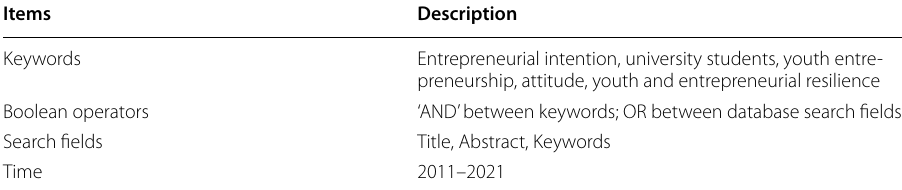
Table 1 Protocols followed for the identification and screening of articles